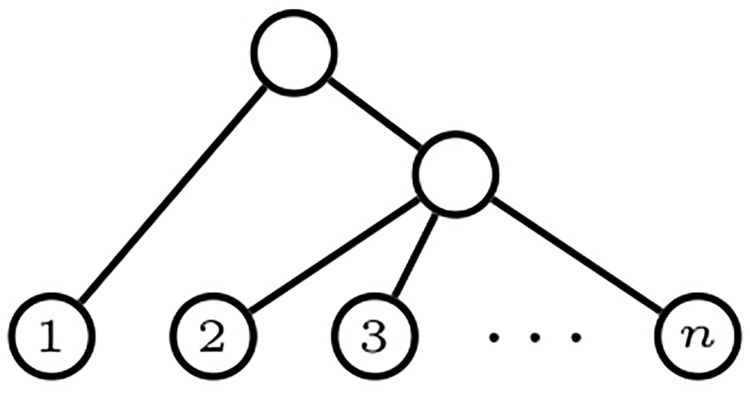
The tree FS1 ⋆ FSn−1.